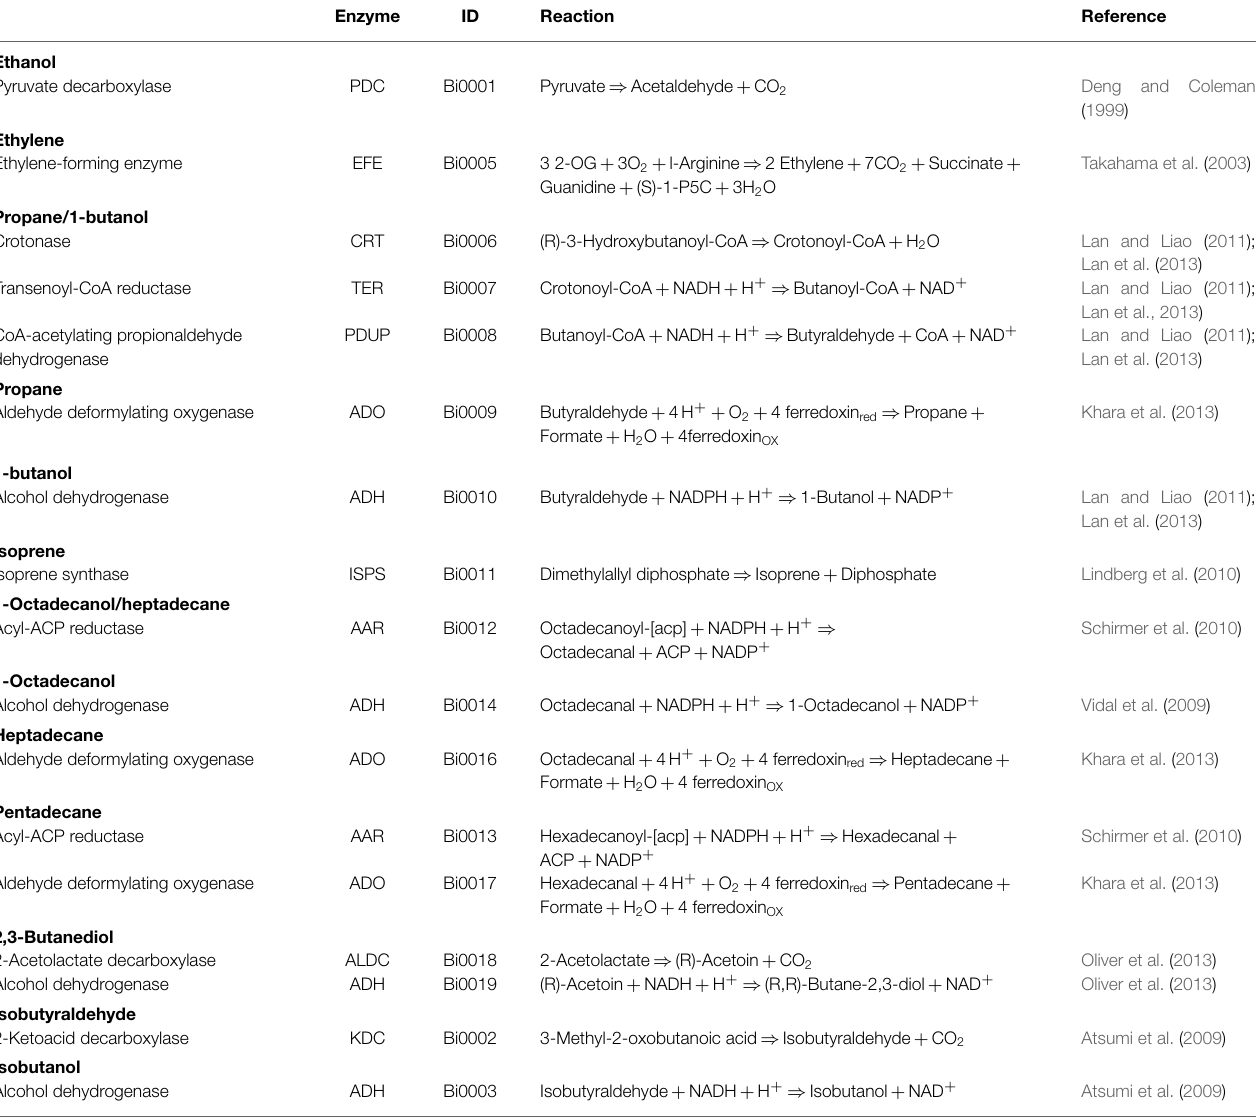
TABLE 4 | Synthesis pathways for cyanobacterial bioproducts